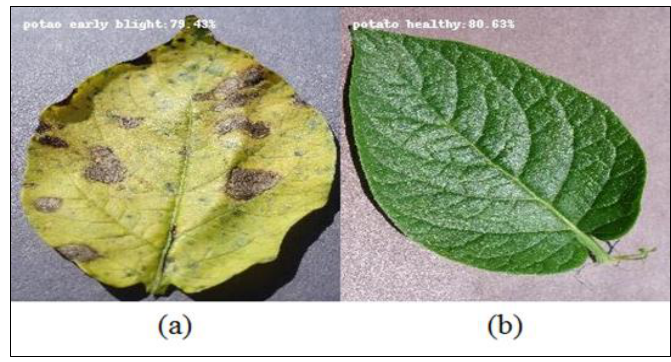
Figure 7. Test image analysis. Source: Authors,